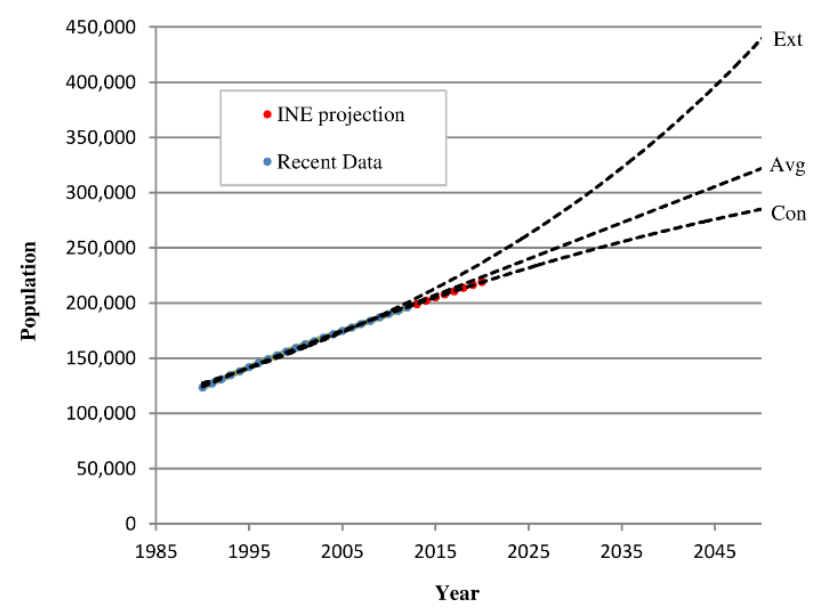
Figure 7. Population growth projections with historic data and expert